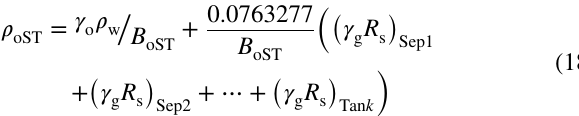
Table 5 The error of DL material